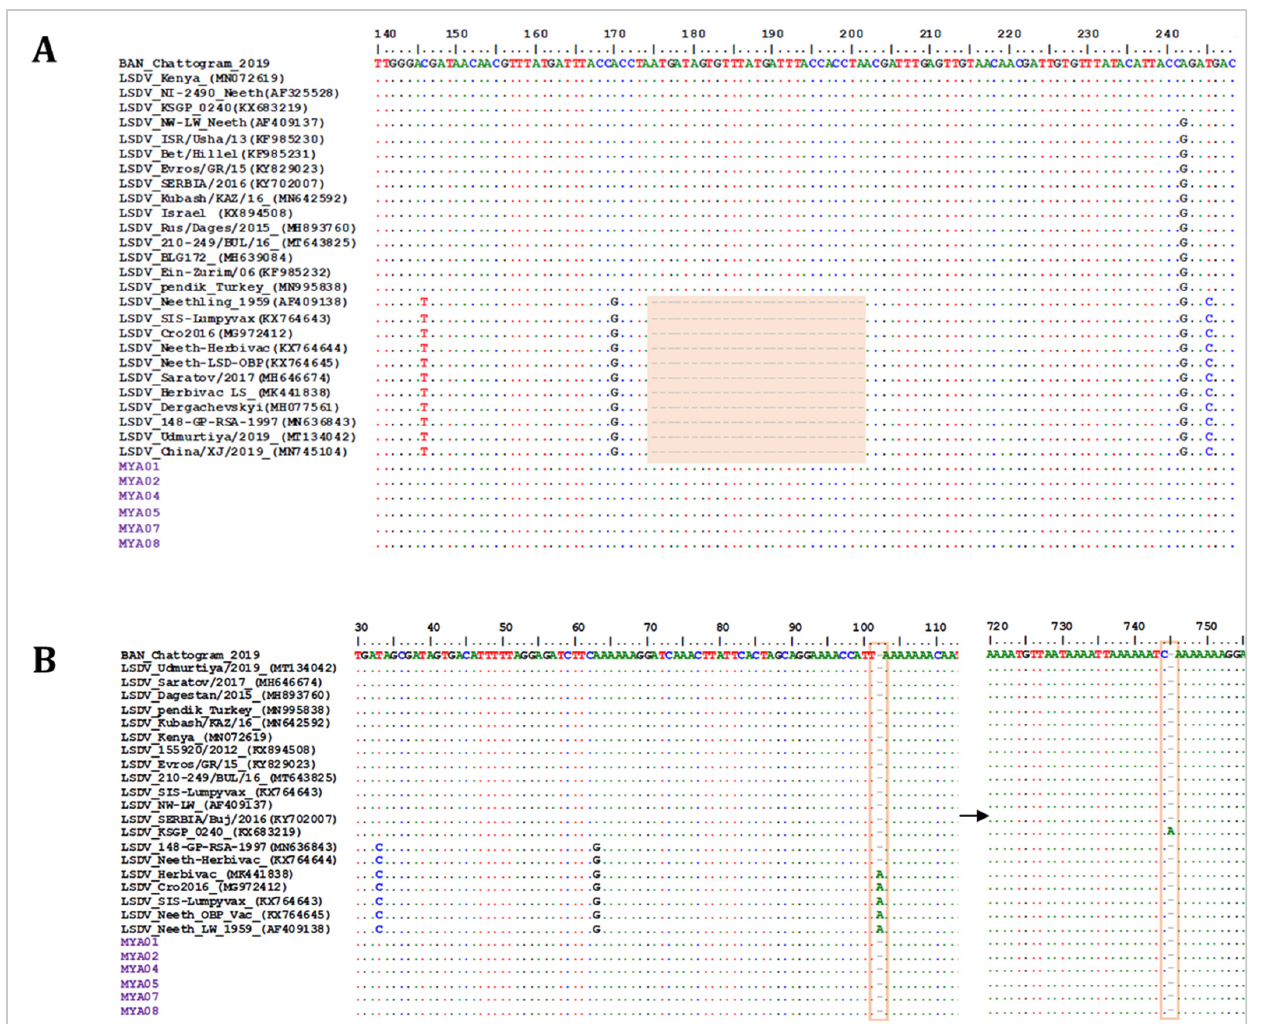
Figure 4. Multiple sequence alignments of the partial nucleotide sequences of ( A ) the EEV glycoprotein gene aligned with representative LSDV sequences, showing the 27-nucleotide deletion absent in Myanmar isolates (highlighted in the box), and ( B ) the B22R gene aligned with representative LSDV sequences retrieved from GenBank. The nucleotide insertion in LSDV Neethling and LSDV KSGP-0240 vaccines that is absent in Myanmar isolates is shown in the blocks. The Myanmar isolates are highlighted in violet, and the dots indicate the identical nucleotides in the alignments. The RPO30 gene phylogenetic tree showed that the Myanmar LSDV sequences clus- tered in the LSDV subgroup SG II with field LSDV strains from Bangladesh and India, LSDV Kenya, and LSDV NI-2490. Notably, the vaccine strain LSDV KSGP-0240 and the Russian recombinant LSDVs (LSDV Udmurtiya/2019 and LSDV Saratov/2017) also clus- tered in SG II (Figure 5A). In addition, the GPCR phylogenetic tree further clustered the Myanmar LSDVs with the Bangladesh and Indian LSDVs, LSDV Kenya, LSDV NI-2490, and the vaccine strain LSDV KSGP-0240, but separate from the Russian recombinant LSDVs. The GPCR sequence alignment also showed a 12-nucleotide insertion in Myanmar LSDVs, a marker for LSDV vaccine strains (LSDV SGP_O-240 and LSDV Neethling vac- cine), which has also been reported in Bangladesh and Indian LSDVs, LSDV NI-2490, LSDV Kenya, and recombinant LSDVs from Russia (Figure 5B).